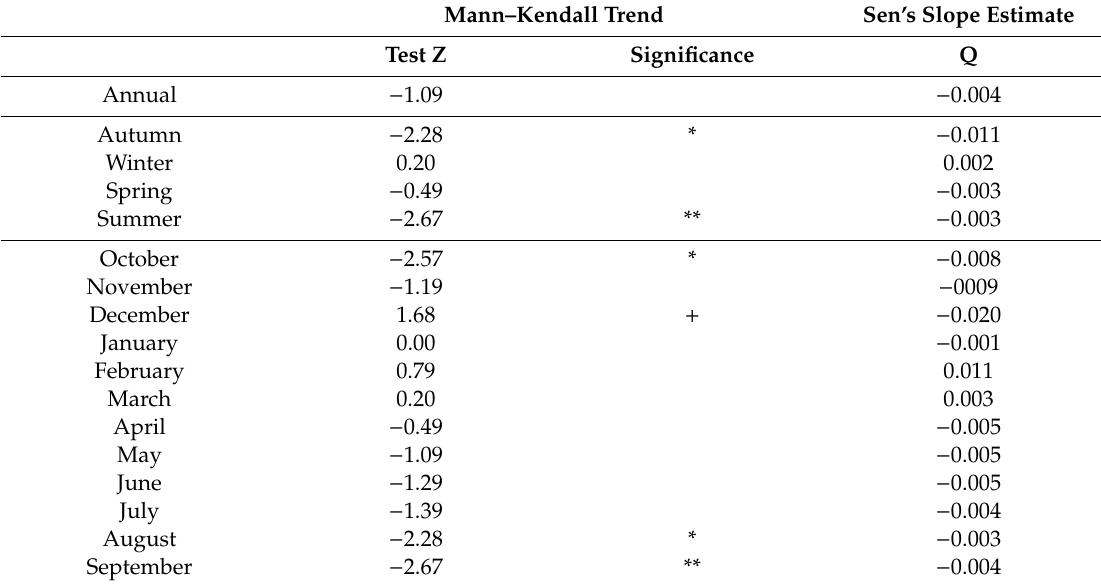
Table 2. Statistics (Z of the Mann–Kendall Test and Q of the Sen’s Slope Estimator) for stream discharge trend analysis.